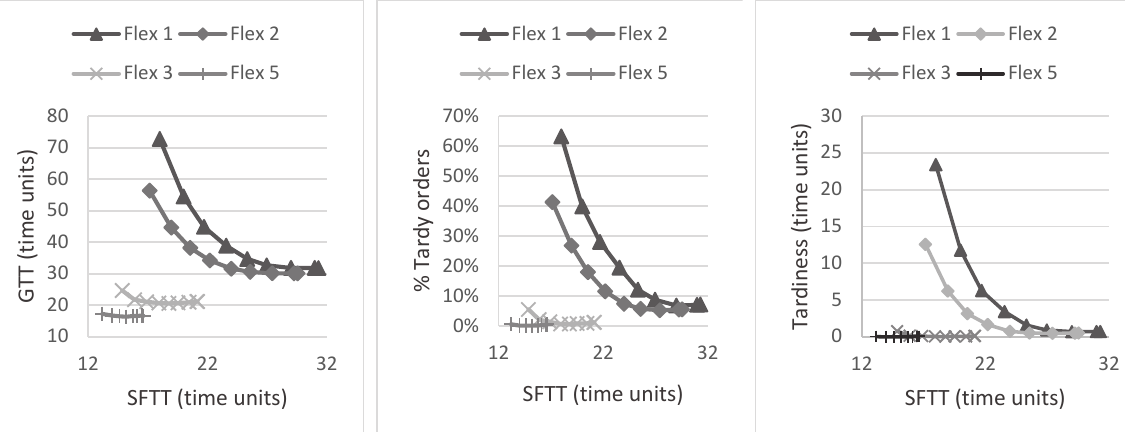
Fig. 1. Impact of Flex1, Flex2, Flex3 and Flex5 on GTT in time units, %Tardy Orders and Tardiness in time units, set against SFTT in time units on